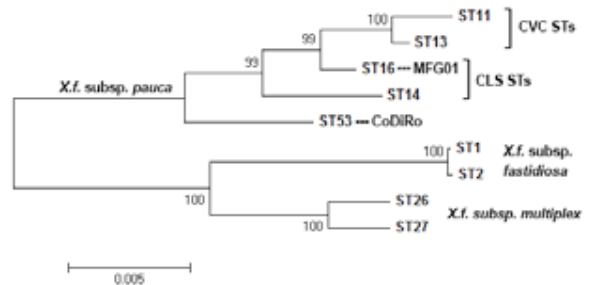
Figure 2. Maximum likelihood tree for concatenate sequenc- es of seven MLST loci from Sequence Types (ST) of Xylella fastidiosa subsp. pauca, X. fastidiosa subsp. fastidiosa, and X. fastidiosa subsp. multiplex present on the MLST database, plus the sequences obtained in the present study the MFG01 strain. Numbers in the nodes are the bootstrap results. CLS = coffee leaf scorch; CVC = citrus variegated chlorosis.